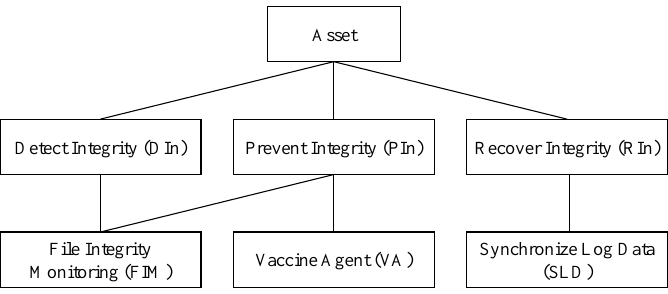
Figure 12. Defense strategies required by asset.